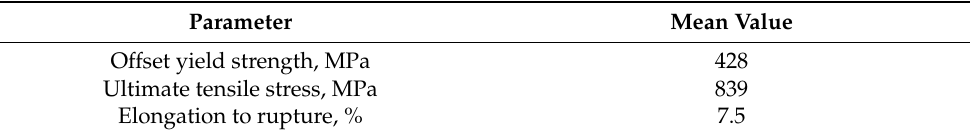
Table 2. E76F steel mechanical properties (evaluated by tension test).